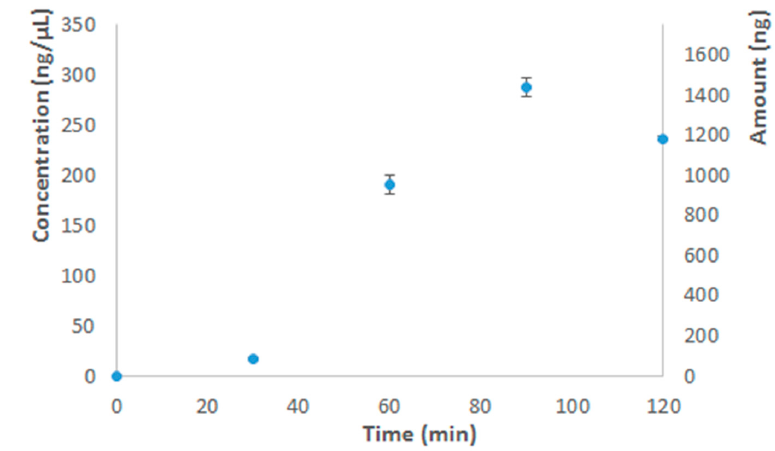
Figure 7. The amplification yield expressed in both concentration (ng/µL) and amount of dsDNA (ng) versus the amplification time with an input of 2.5 ng of purified DNA (TaqMan Control Genomic DNA). The error bars are ± 1 standard